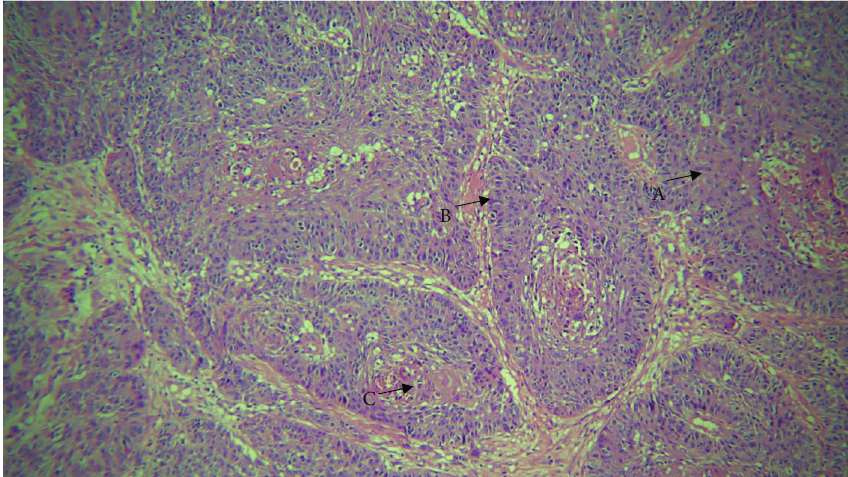
Figure 6: 10 × view. A: squamous cells; B: basaloid cells with peripheral palisading; and C: comedo